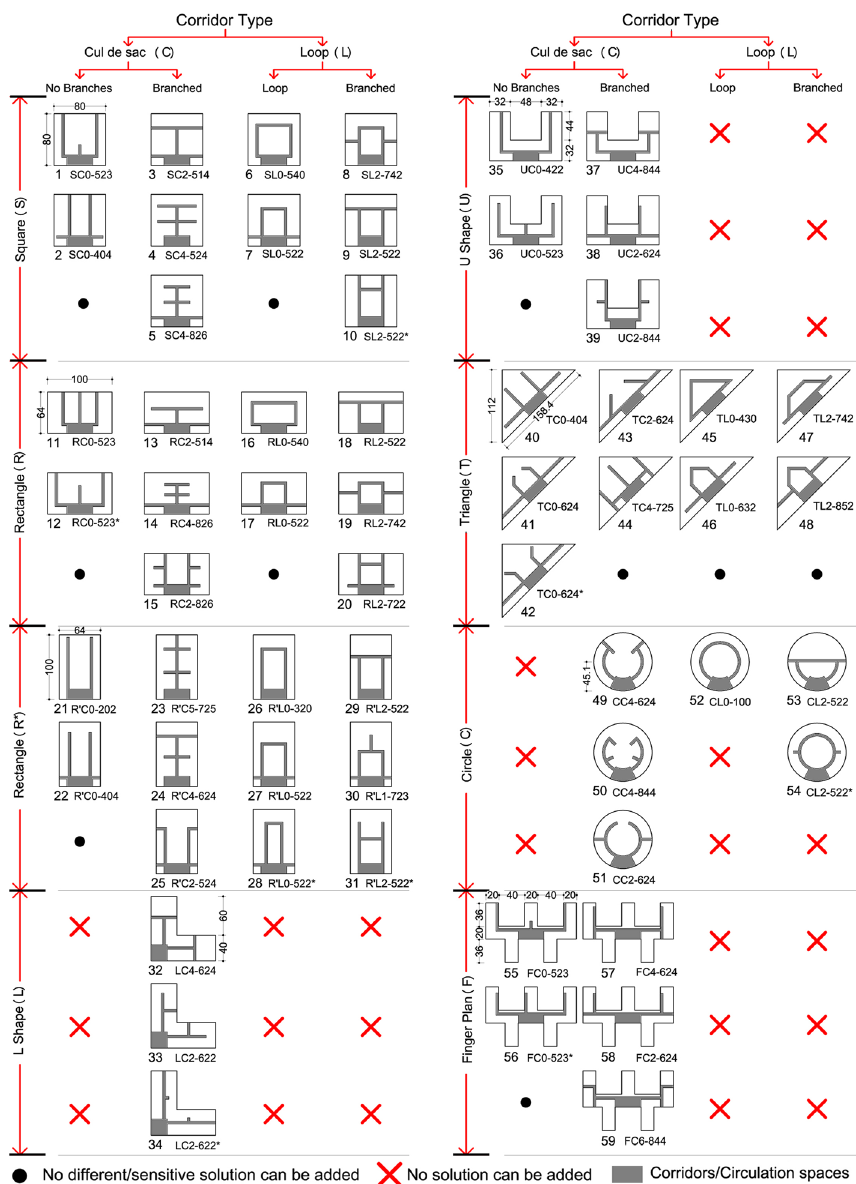
Fig. 2 Proposed CCAs to be studied. Notes: (1) All dimensions presented are in meters. (2) For all CCAs, proposed building layouts’ area is 6400m 2 , the area of the entrance lobby is 640 m 2 , the total area of the circulation spaces is 640 m 2 , and the corridor width is 4m. (3) All CCAs have been numbered serially from 1 to 59 (as presented below each CCA) and structured to have a code; this code contains 7 digits structured as (Xxa-bcd*); where ( X ) is a letter that denotes to the used BLS among the 8 proposed ones; ( X ) can be (S, R, R ′ , L, U, T, C or F) which denotes square, rectangle with an entrance on the longer side, rectangle with an entrance on the shorter side, L shape, U shape, triangle, and circle or finger plan, respectively; ( x ) is a letter that refers to one of two considered corridor types, either cul-de-sac (C) or looped (L). (a), (b), (c), and (d) are separated 1-digit numbers of branches, segments, nodes, and dead ends/exits, respectively. (*) is added only to differentiate the code if all previous features are the same. For example, Alt (TC0-624) refers to the CCA designed in a T-shaped building layout and with cul-de-sac corridors, no branches from the main corridor, 6 segments, 2, nodes and 4 dead ends/exits. Alt (TC0-624*) is another CCA with the same